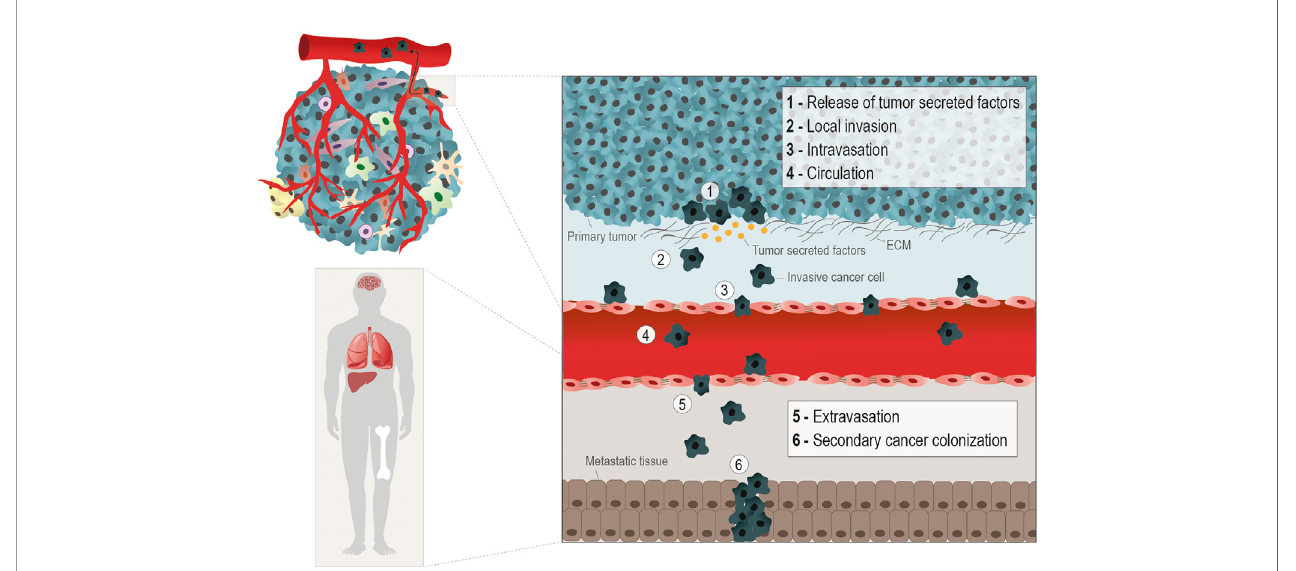
FIGURE 1 | Hematogenous metastatic route. The metastatic cascade starts with molecular and morphological changes in cancer cells, enabling their release from the primary tumor. The production of tumor secreted factors ( e.g. MMPs) by cancer cells to degrade the extracellular matrix (ECM) (1), helps the gain of migratory and invasive abilities (2). The metastasizing cancer cells, depending on the cancer type, rely on epithelial to mesenchymal transition (EMT), in which cancer cells acquires a mesenchymal phenotype through the loss epithelial cell-cell contacts, as E-Cadherin, to facilitate the penetration into the basal membrane. However, in other scenarios collective or cluster ‐ based migration and invasion can contribute to cancer cell intravasation independent of EMT. The different phases of the hematogenous metastatic cascade are: local invasion (1 and 2); intravasation into vessels (3); circulation into the bloodstream (4); extravasion into a distant organ or tissue (5), and the formation of a secondary tumor in the metastatic niche (6). The metabolic remodeling during the metastatic processes is crucial for the ef fi cient colonization of cancer cells in distant sites, typically nutrient and oxygen-rich areas, as lungs, liver, bones and